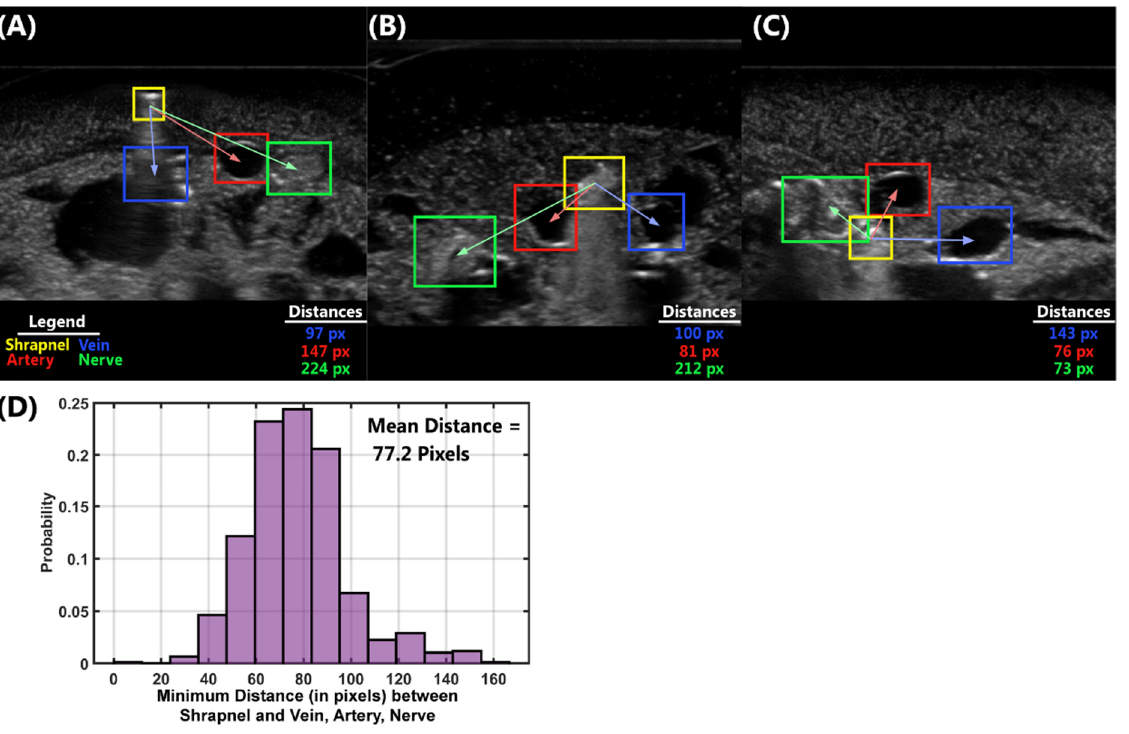
Figure 7 . Results for the triage metric determined from the multi-class ShrapOD. ( A – C ) Distance measurements from center point of shrapnel to each neurovascular feature for three different ultra- sound images of varying distances to shrapnel. Only prediction masks are shown (shrapnel = yellow, vein = blue, artery = red, and nerve = green) and distances, in pixels, from shrapnel to the vein (blue), artery (red), and nerve (green) are shown. ( D ) Probability distribution of minimal distances for each test image containing predictions for all four features. The mean minimal distance across all test images is shown.